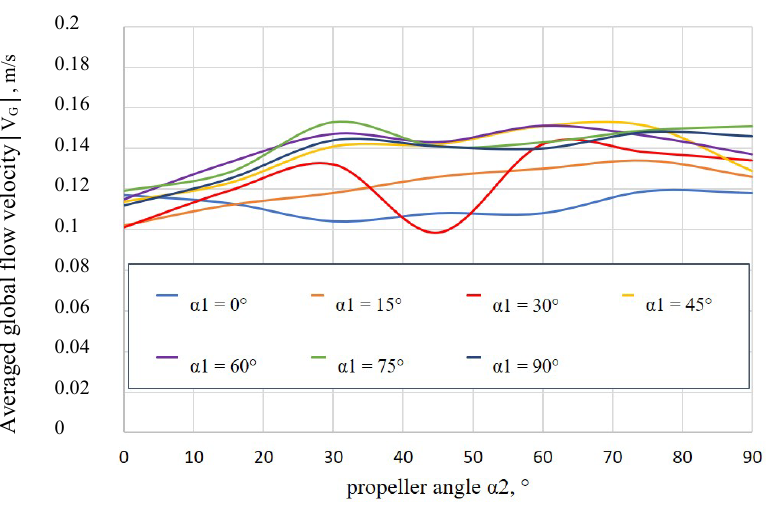
Fig. 4 . Fluid velocity profile as function of the rotation angles of mixer 2 (α2), for seven different rotation angles of mixer 1 (α1). As expected, low values are determined in cases, where the propeller is located with the shaft along the tank radius or slightly tilted from the parallel orientation. Indeed, for α =